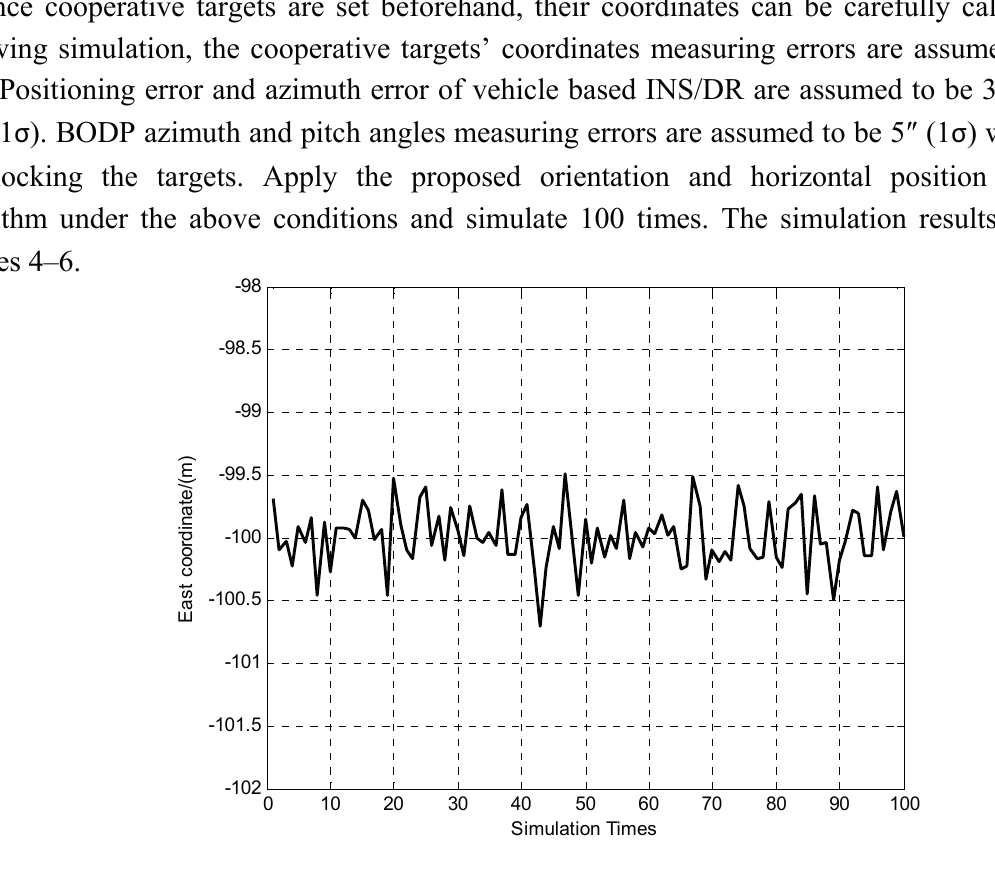
Figure 4. 100 times of east coordinate determination